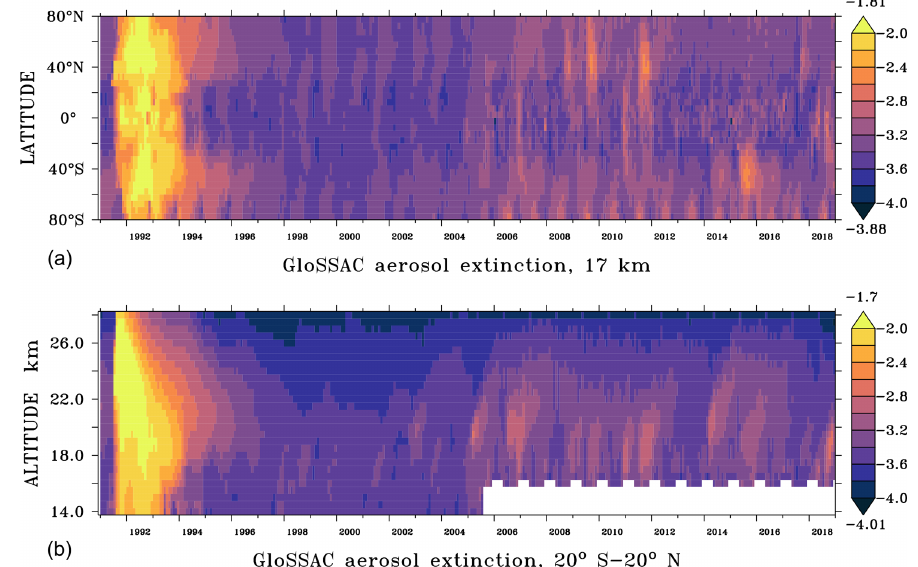
Figure C1. GloSSAC aerosol extinction on a logarithmic scale log(km − 1 ) for the 525nm wavelength from the January 1991–December 2018 zonal mean at 17km altitude (a) and in vertical distribution for tropical regions 20 ◦ S–20 ◦ N (b) . Maximum and minimum values appear above (dark red) and below (violet) the colour keys, respectively. White: no